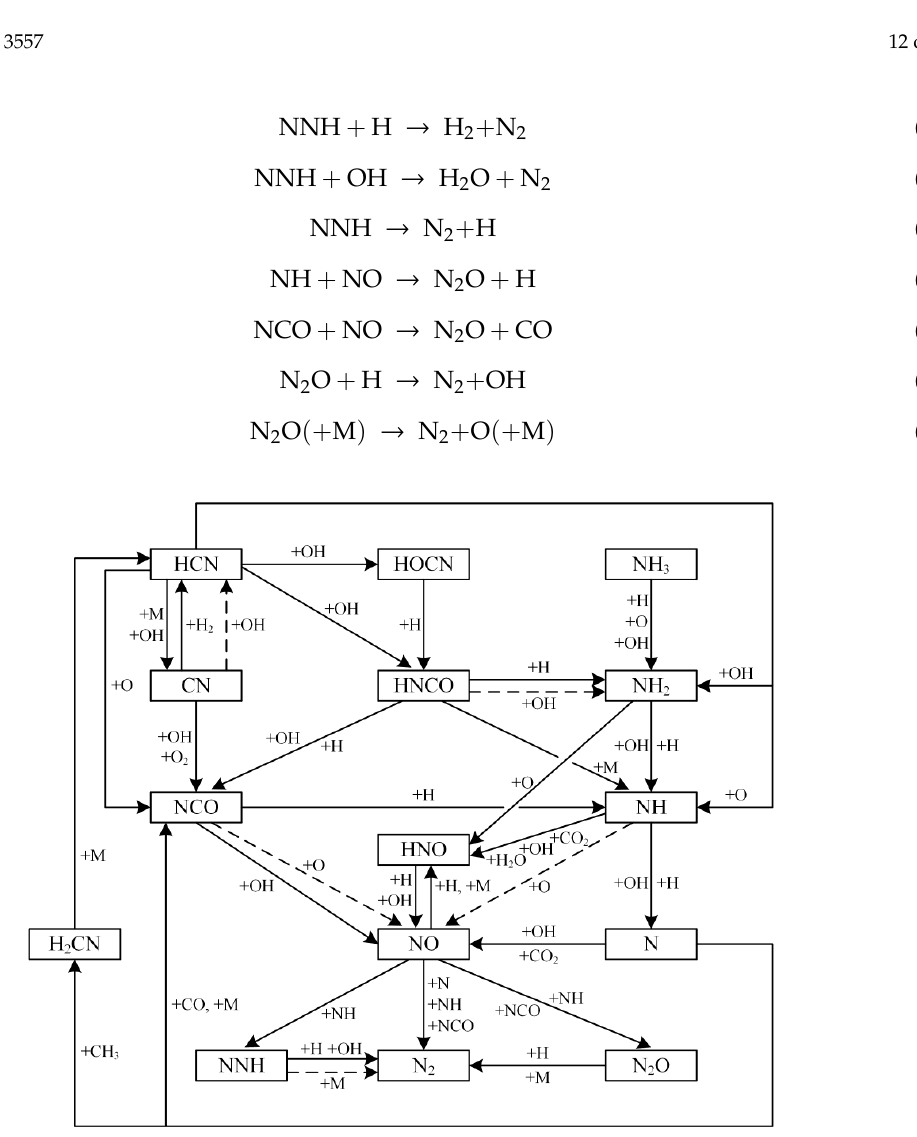
Figure 10. Reaction path diagram for the fuel-N conversion under a high temperature and strong reducing atmosphere conditions in staged air and O 2 /CO 2 combustion.